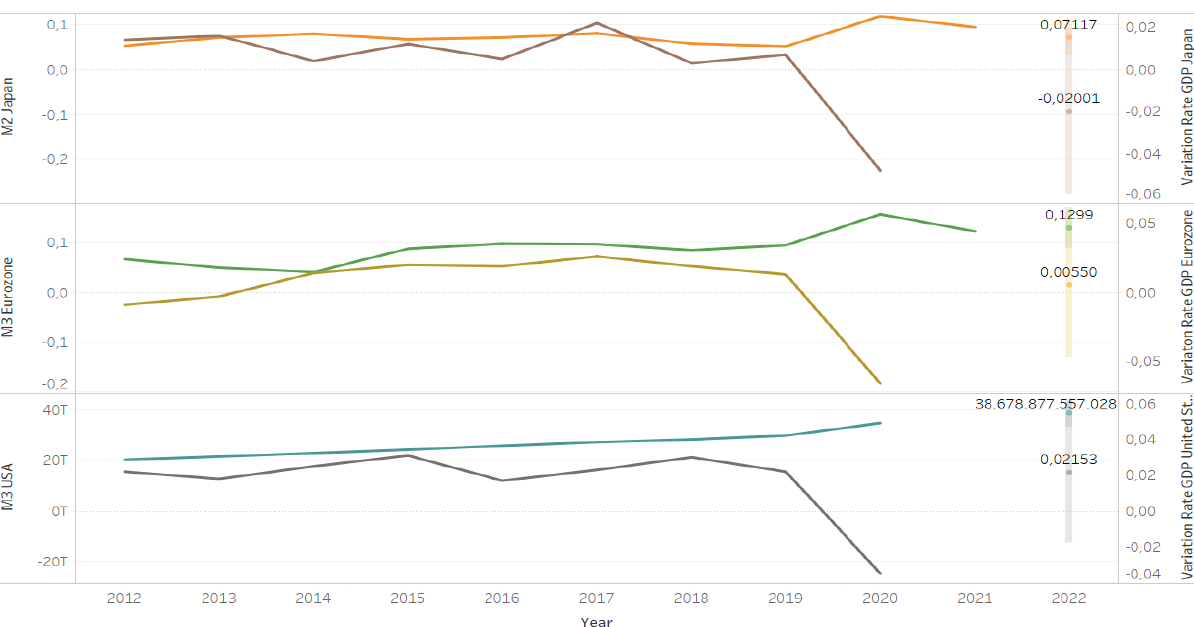
Figure 3. M2–M3 ratio with variation rate/GDP and prediction. Source: own elaboration through Tableau Desktop professional edition and data from International Monetary Fund, ECB, Fed, and BOJ.